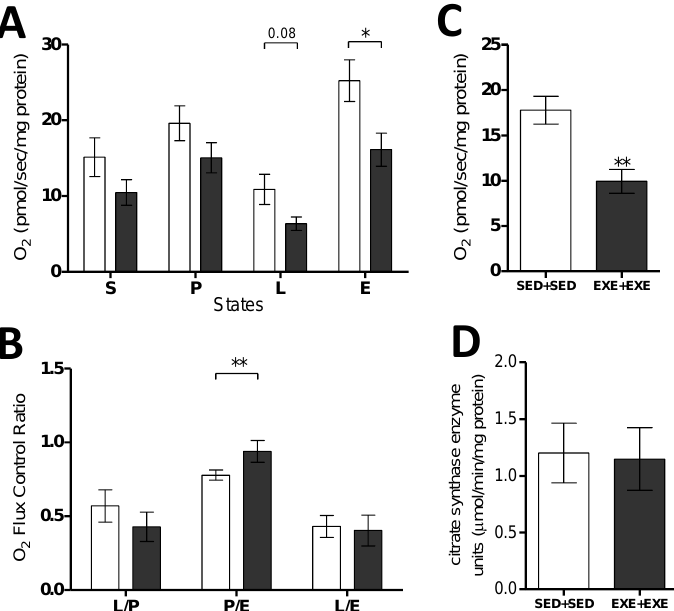
Figure 2. Physical exercise reduces mitochondrial capacity in tumor tissue of TNBC (4T1 cells). ( A ) Oxygen consumption rates in states with substrates glutamate, malate, and pyruvate (S); ADP (phosphorylating, P); oligomycin (nonphosphorylating, leak, L); CCCP (uncoupled, E). SED + SED n = 9; EXE + EXE n = 7. ( B ) Flux Control Ratios: leak as a fraction of phosphorylation (L / P); phosphorylation as a fraction of the maximum electron transport capacity (P / E); leak as a fraction of the maximum electron transport capacity (L / E). SED + SED n = 9; EXE + EXE n = 7. ( C ) Residual oxygen consumption (ROx) after antimycin A. SED + SED n = 9; EXE + EXE n = 7. ( D ) Activity of the citrate synthase enzyme. SED + SED n = 9; EXE + EXE n = 7. White bars = SED + SED, gray bars = EXE + EXE. Unpaired t -test, Means ± SEM. * p < 0.05; ** p < 0.01.